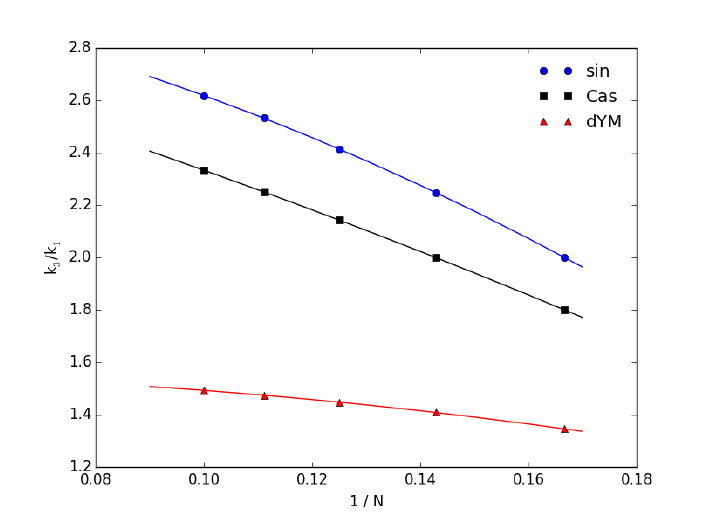
Figure 6 . Polynomial (cid:12)ts for T 3 =T 1 k -string ratios in dYM and noised ( Casimir for SU(6 dYM: 1 : 551 + 0 : 390x